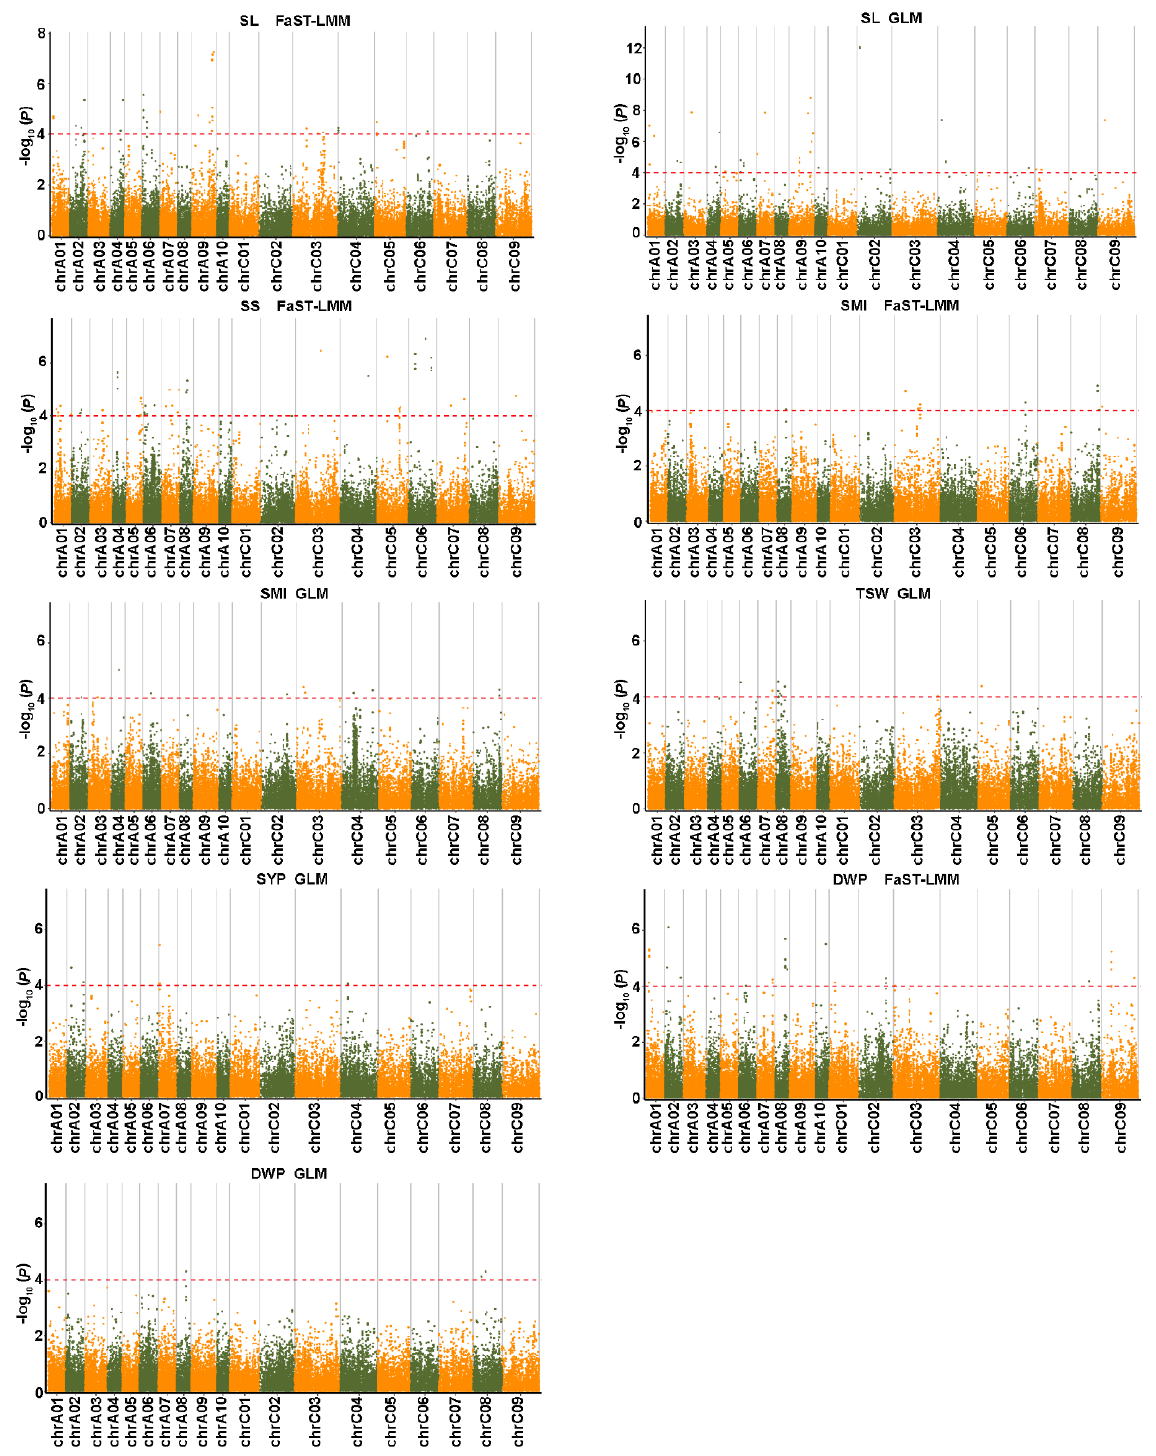
Figure 6. Manhattan plots from association analysis of six yield-related traits using the optimal statistical models. The X-axis indicates the nineteen chromosomes and the Y-axis represents − log10 ( p ) values of the SNP marker. The red dashed line represents the significance threshold ( p < 0.0001). GLM, general linear model; FaST-LMM, factored spectrally transformed linear mixed model; SL, silique length; SMI, siliques on main inflorescence; SS, seeds per silique; TSW, thousand-seed weight; SYP, seed yield per plant; DWP, dry weight per plant. The graphs show the results in a year